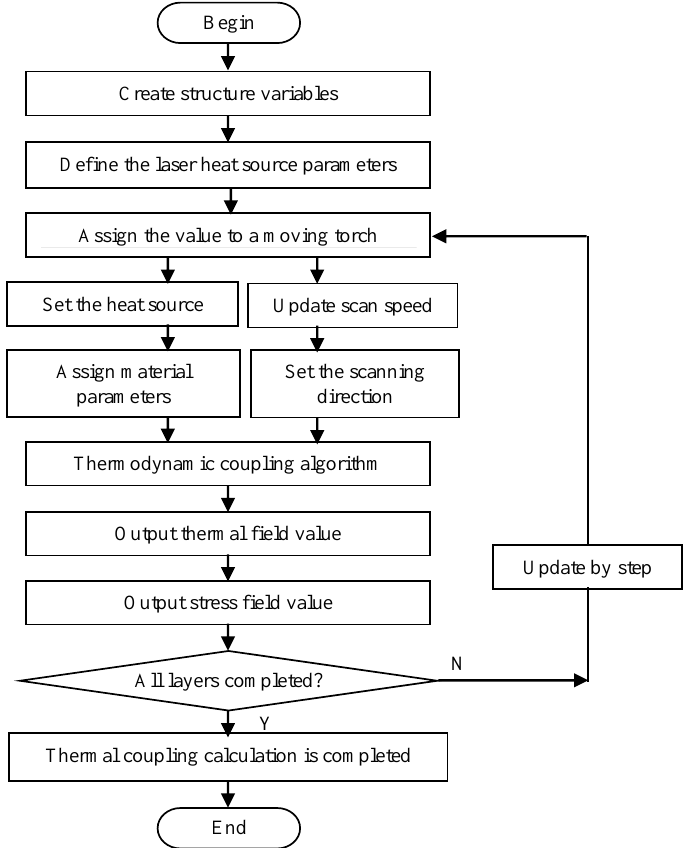
Figure 2. The flow of dynamic heat source algorithm.